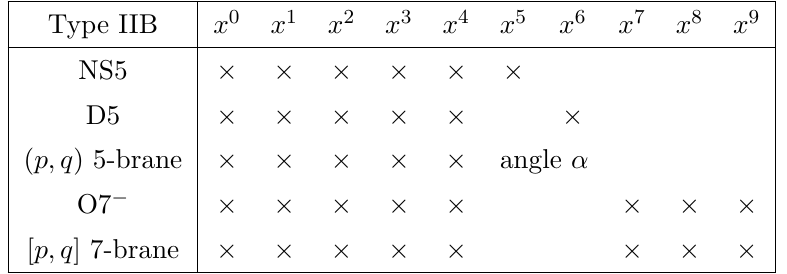
Table 8 . Type IIB 5-brane web set-up with O7 (cid:0) plane: spanned by the various branes and the orientifold plane. A ( p; q ) 5-brane is a line of slope tan( (cid:11) ) = q(cid:28) 2 = ( p + q(cid:28) 1 ) in the x 5 ; 6 plane where the axiodilaton is (cid:28) = (cid:28) 1 + i(cid:28) 2 . In this paper all the brane webs are drawn for the value (cid:28) = i , so that tan( (cid:11) ) = q=p .